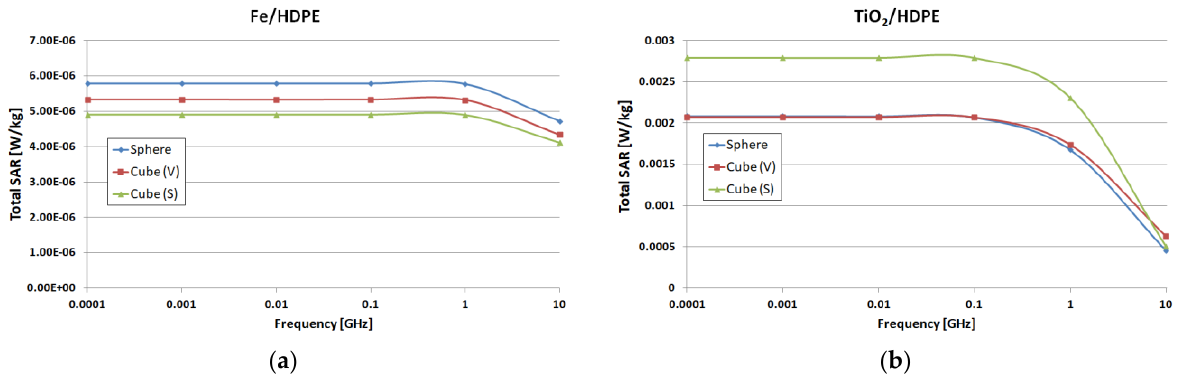
Figure 4. Total SAR (W/kg) results for spherical particles for the equivalent cubical particles (same volume — V) and equivalent cubical particles (same surface — S), respectively: ( a ) metallic (Fe) par- volume—V) and equivalent cubical particles (same surface—S), respectively: ( a ) metallic (Fe) particle ticle inside HDPE; ( b ) dielectric (TiO 2 ) particle inside HDPE. inside HDPE; ( b ) dielectric (TiO 2 ) particle inside